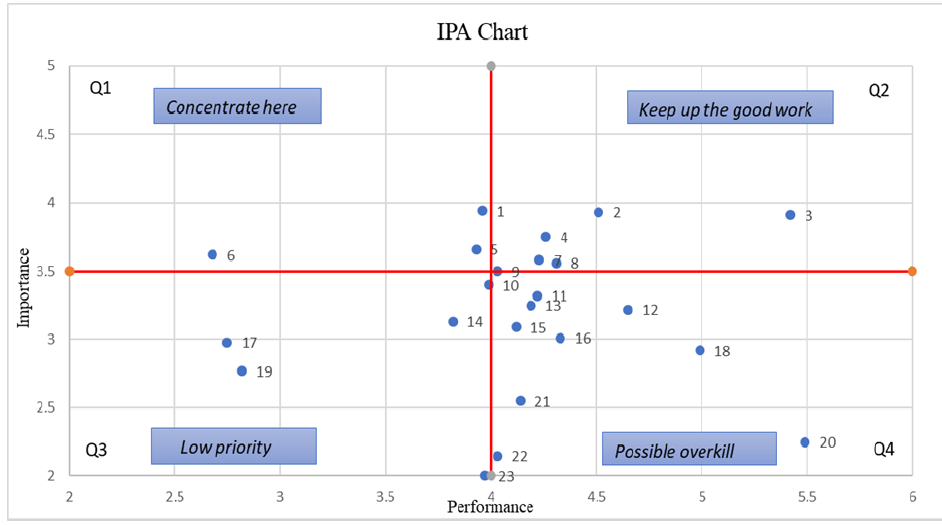
Figure 5. IPA results.